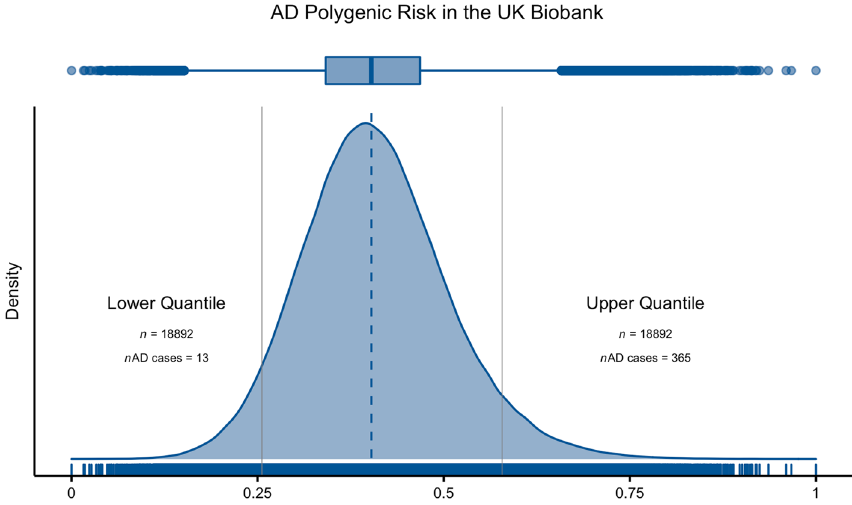
Figure 1. Density plot with the distribution of PRS when applied to samples from the UKBB. Solid grey vertical lines depict the 5% extremes of the PRS distribution. PRS were rescaled between zero and